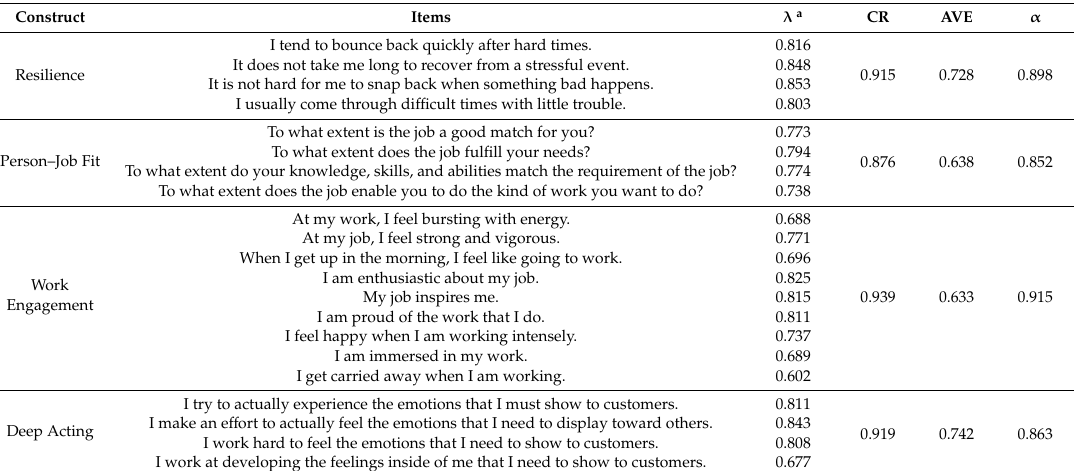
Table 1. Reliability and convergent validity results.